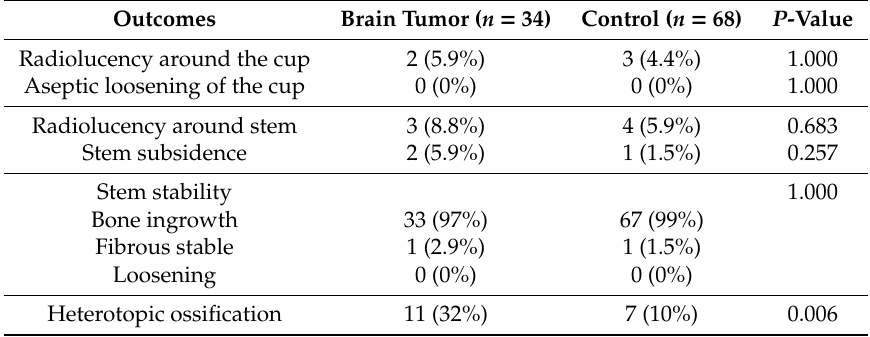
Table 6. Radiographic outcomes of THA.